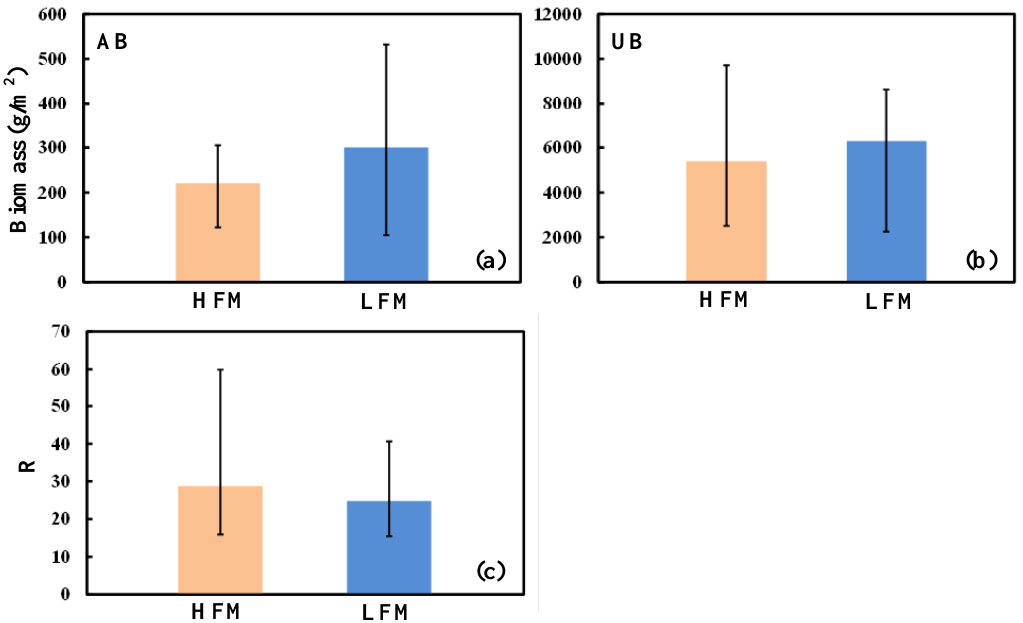
Figure 6. The aboveground ( a ) and underground ( b ) biomass of the Nagqu River Basin; ( c ) the value of R in the Nagqu River Basin. The vertical line indicates the error limit, HFM is the high-frequency mode, and LFM is the low-frequency mode.